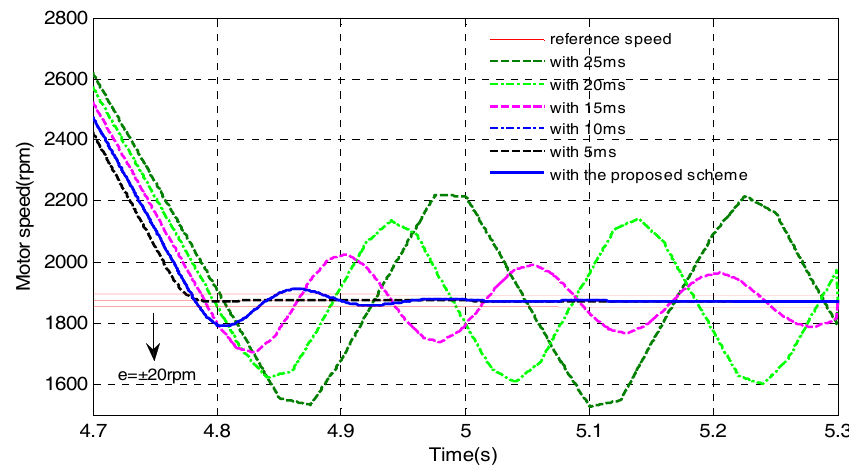
Figure 8. The speed synchronization responses in detail in simulations.